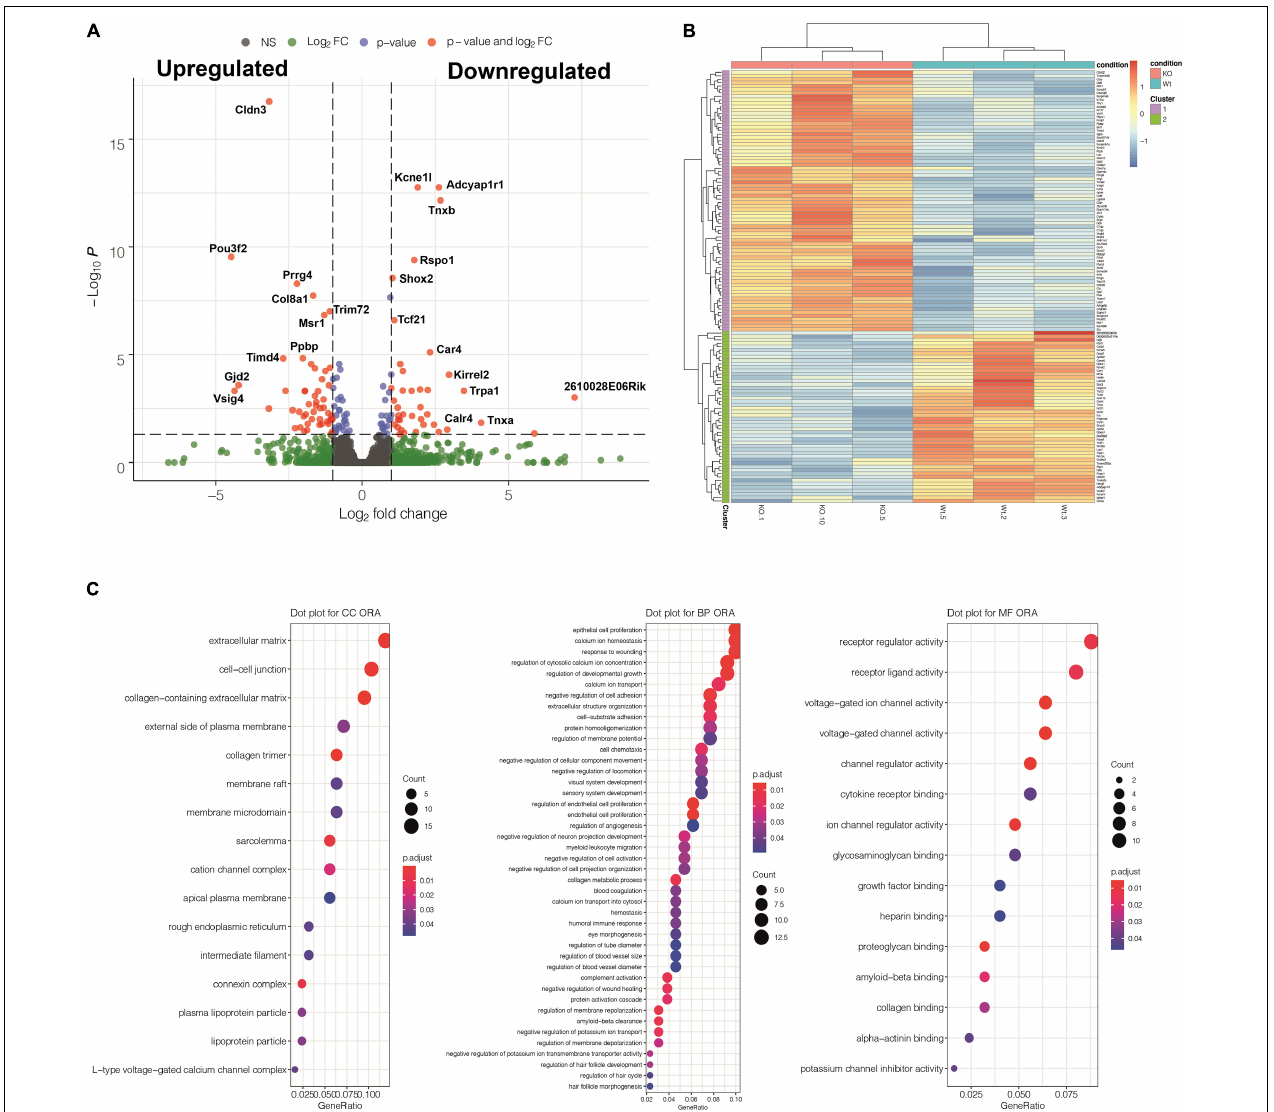
FIGURE 7 | Summary of the results obtained from a transcriptomic comparison between three Tnnt2 Cre / + ; WT1 flox / flox mutant and three control embryos (stage E13.5). (A) Volcano plot showing differentially expressed genes (DEGs) detected by DESeq2. (B) Heatmap showing a cluster analysis of DEGs based on the K-means method. (C) Gene Ontology Analysis implemented through over representation analysis (ORA) test for molecular function, biological process and cellular component categories. Regulation of calcium and voltage-gated ion channels are among the most overrepresented biological processes and molecular functions affected by the WT1 loss of function in the Tnnt2 lineage. Genes with significant p -Values are detailed in Supplementary Table 3